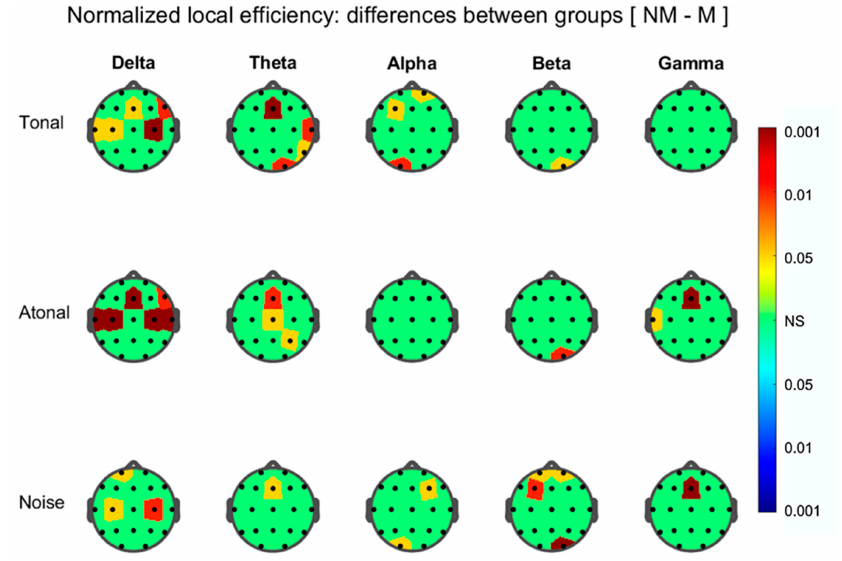
Figure 12. As in Figure 9 but for the difference between non-musicians (NM) and musicians (M) of node normalized local efficiency, during the three auditions indicated at left.